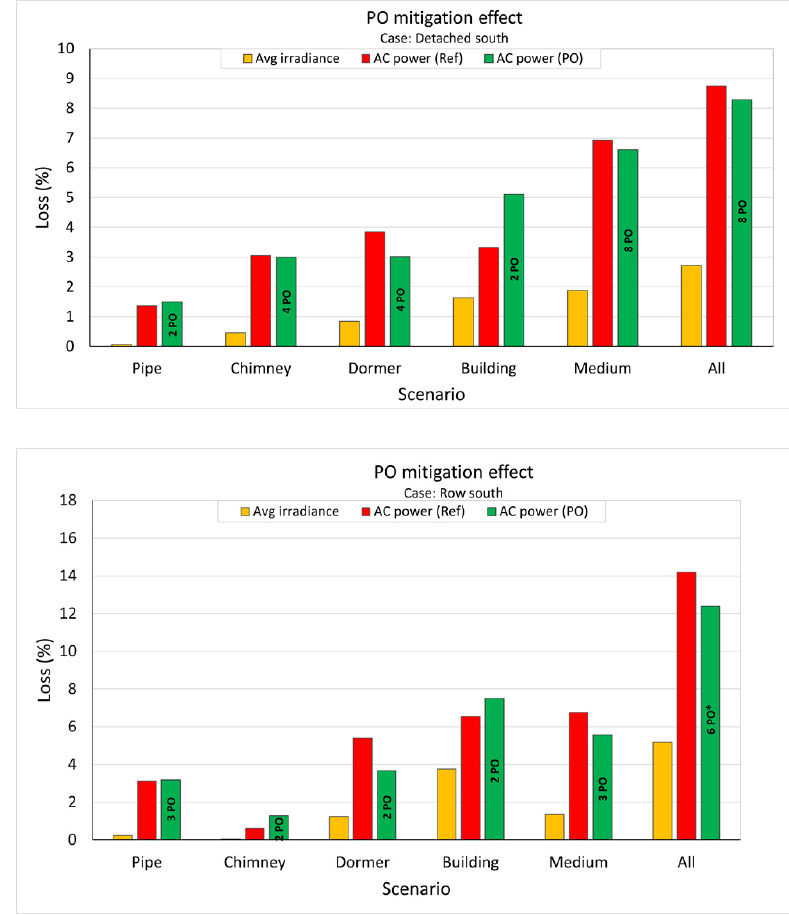
Figure 16. Annual irradiance and AC energy losses per building and system type, for a South orientation. The top displays a detached house and the bottom a row house as defined in the shading scenario Section 2.3.